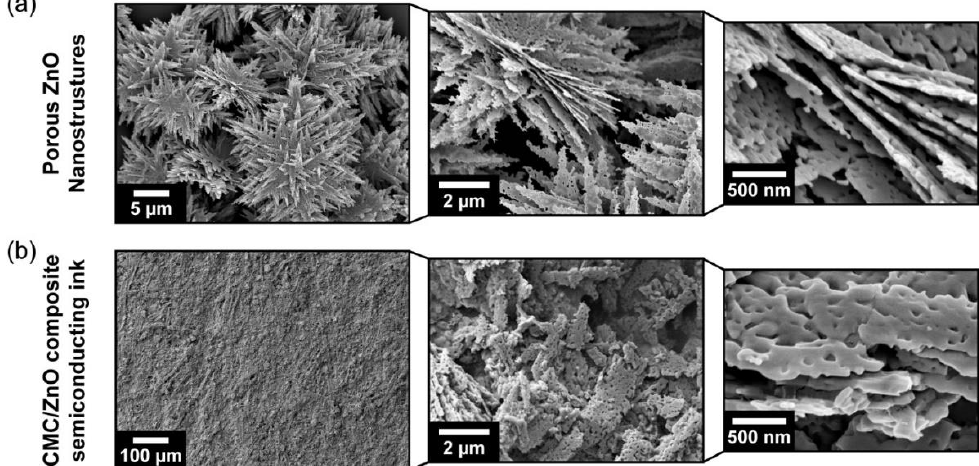
Figure 2. SEM images of ( a ) the porous ZnO structures assembled into 3D flower-like hierarchical structures obtained by hydrothermal method assisted by microwave irradiation, and ( b ) the screen- printed CMC/porous ZnO nanostructures composite ink on office paper.